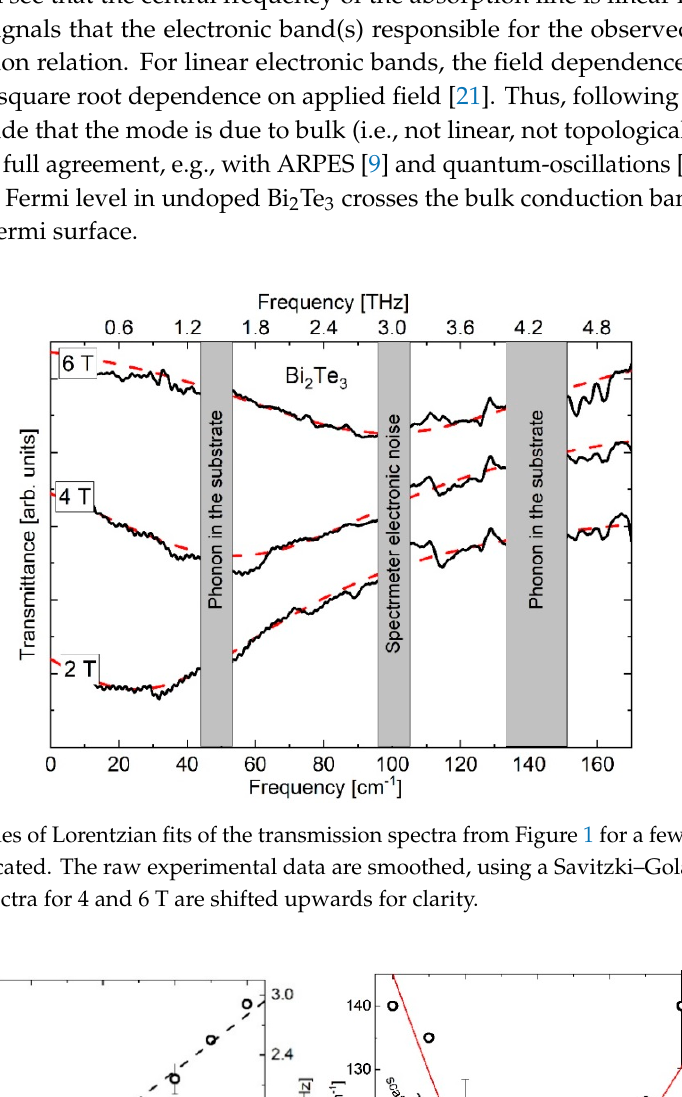
Figure 3. Examples of Lorentzian fits of the transmission spectra from Figure 1 for a few magnetic-field strengths as indicated. The raw experimental data are smoothed, using a Savitzki–Golay method [23]. Note that the spectra for 4 and 6 T are shifted upwards for clarity.